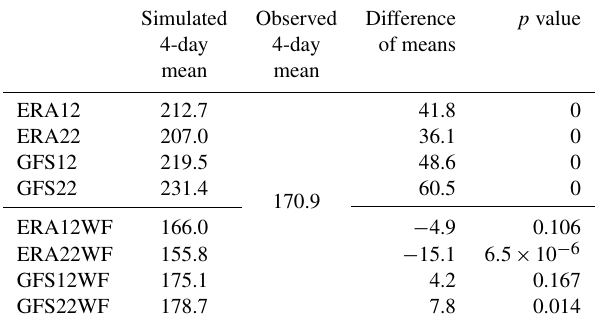
Table 8. The p values from two-sample t tests of the 10min ob- served power and the 10min simulated power from different model